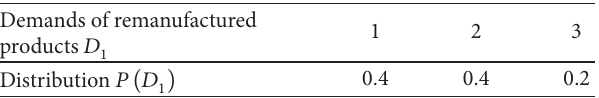
Table 3: The distribution of the demands of remanufactured products in stage 1.